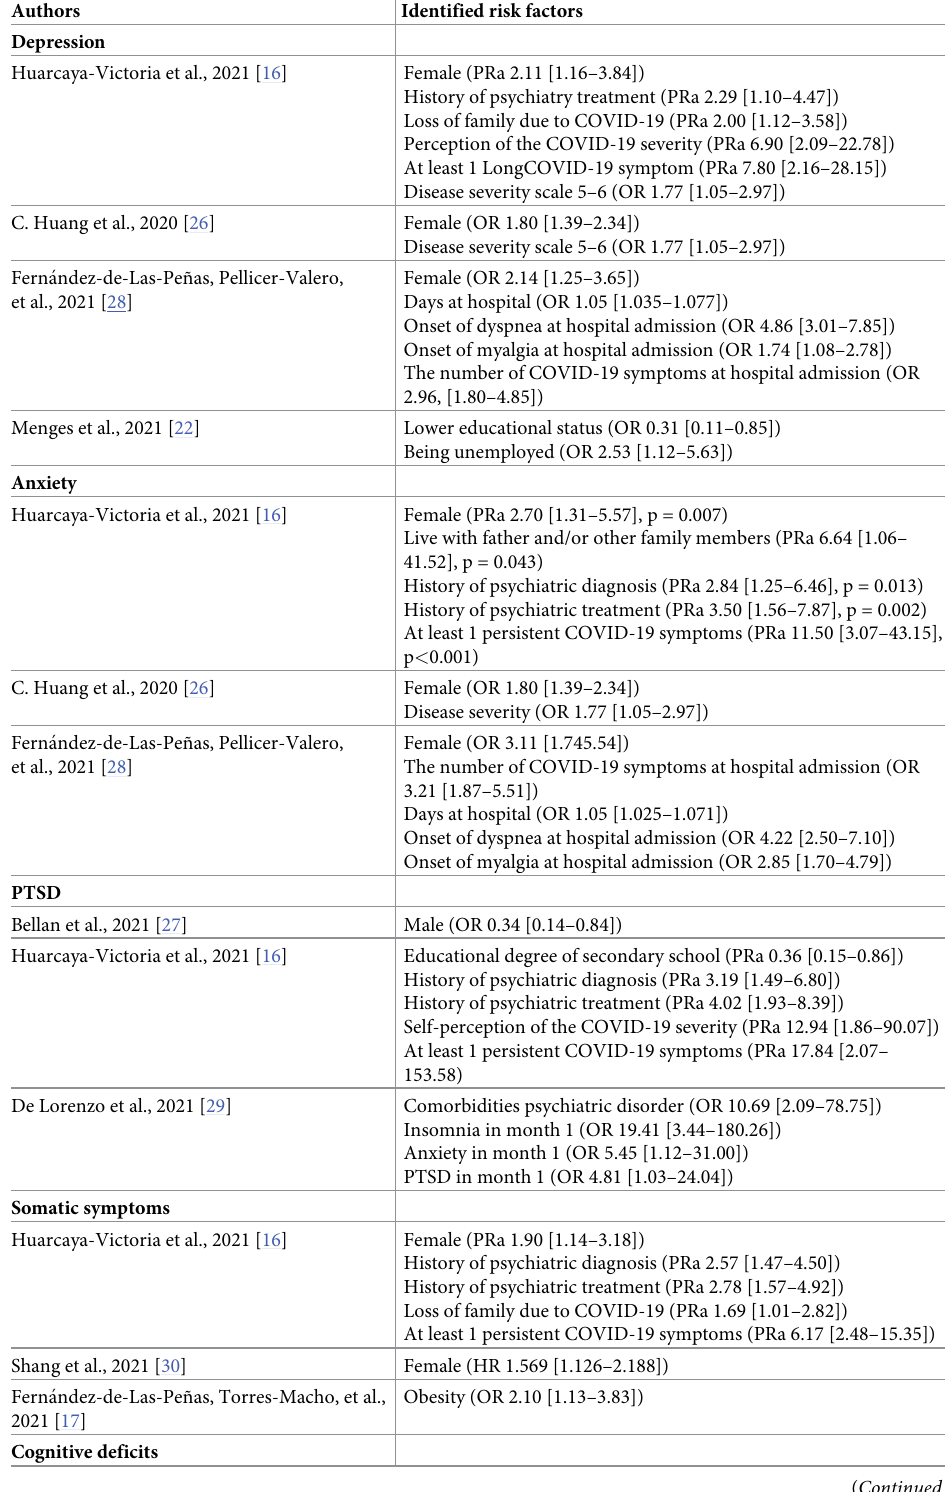
Table 2. Risk factors for psychiatric symptoms among Long COVID participants from multivariate